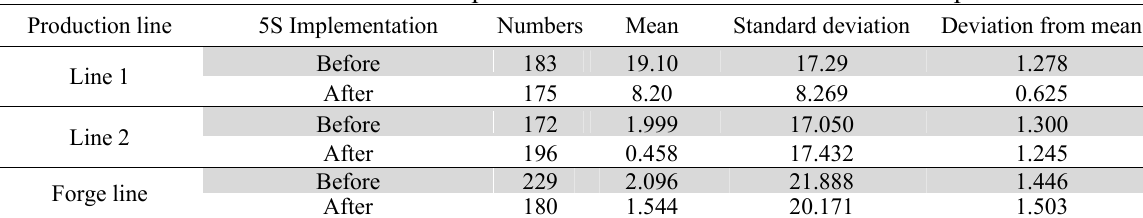
The results of statistics before/after 5S implementation in terms of minutes of waste production Production line